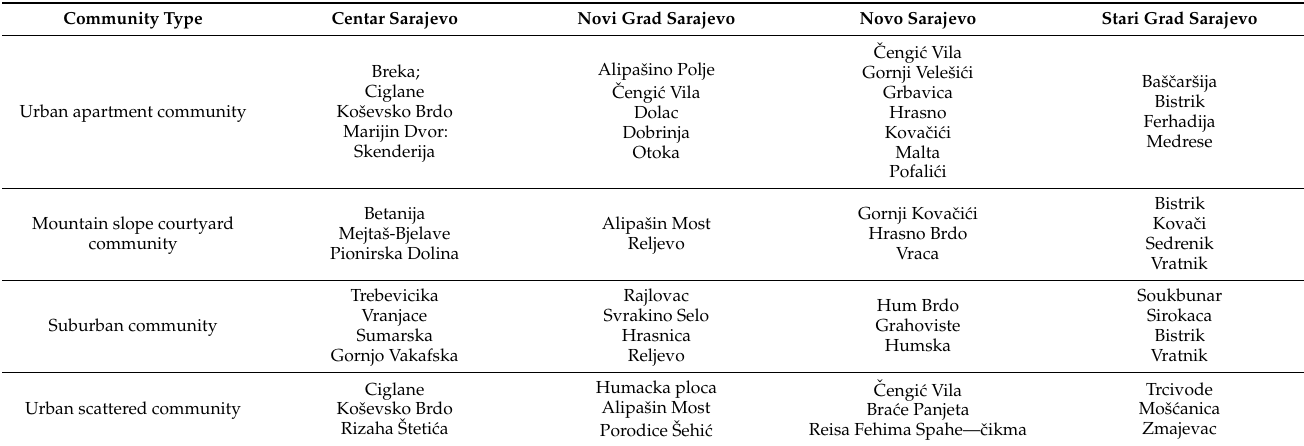
Table A2. Case communities in